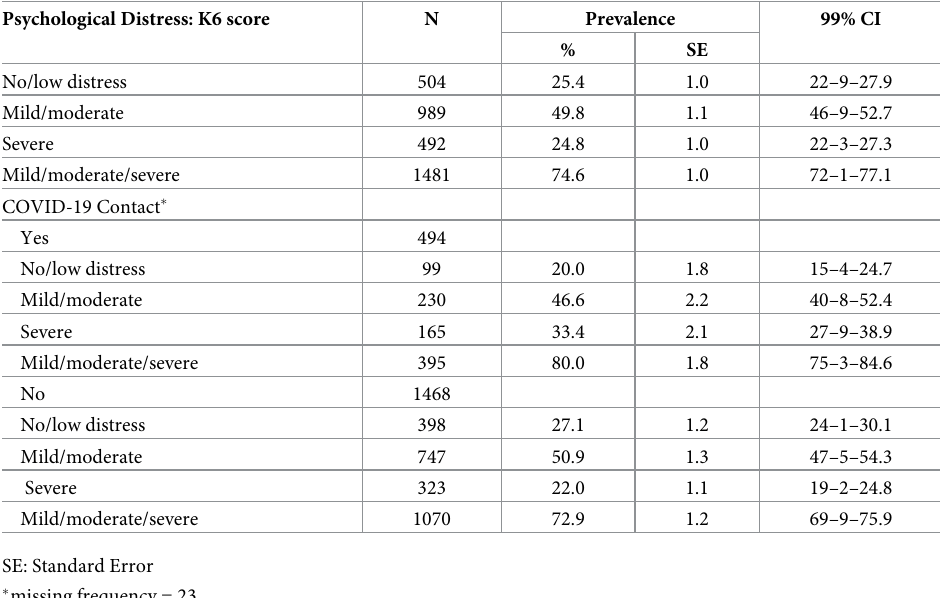
Table 2. Prevalence of psychological distress (N = 1985). Psychological Distress: K6 score